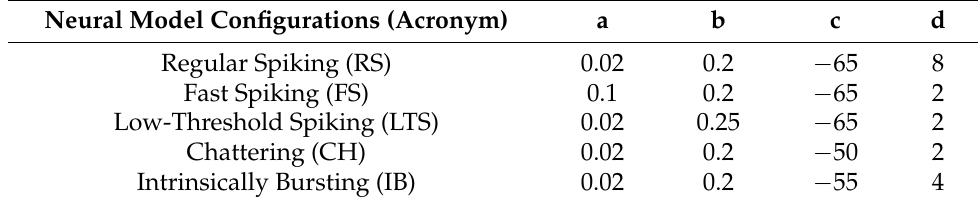
Table 2. Typical values of principal